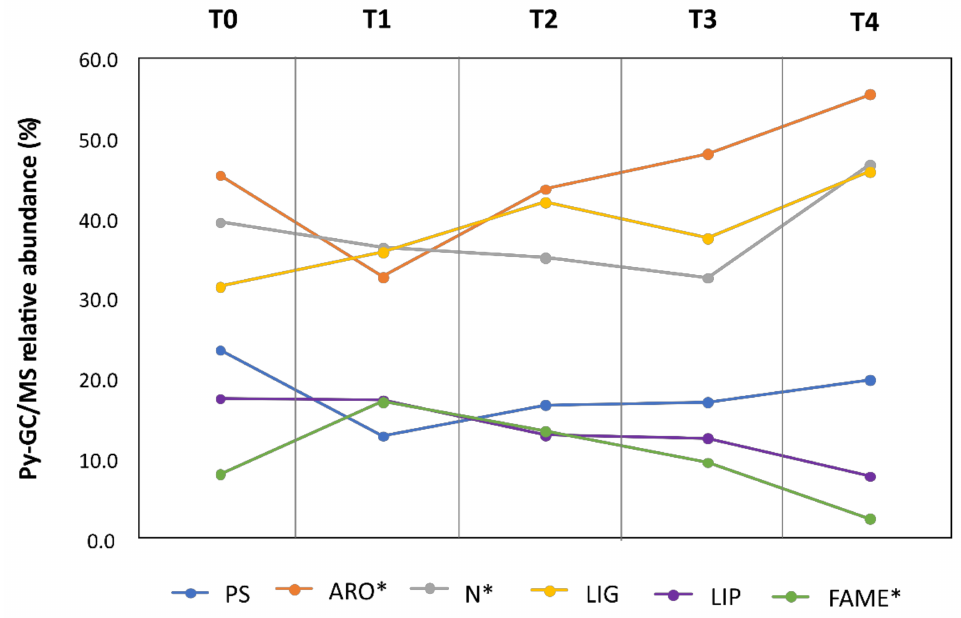
Figure 2. Evolution of the relative abundance (average; %) of main biogenic compounds released by analytical pyrolysis (Py-GC/MS) during the composting process. Compounds families with (*) indicate that values are 10-fold represented ( ×